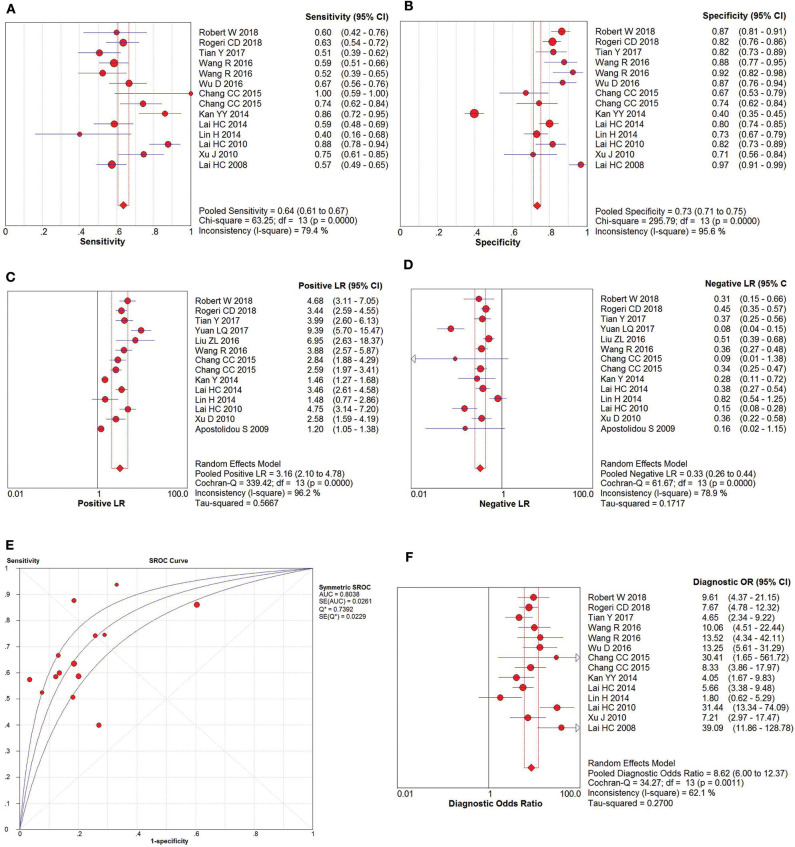
SROC curve (E) and forest plots of sensitivity (A), specificity (B), positive-likelihood ratio (PLR) (C), negative-likelihood ratio (NLR) (D) and diagnostic odds ratio (DOR) (F) of SOX1 hypermethylation in the diagnosis of cervical cancer.